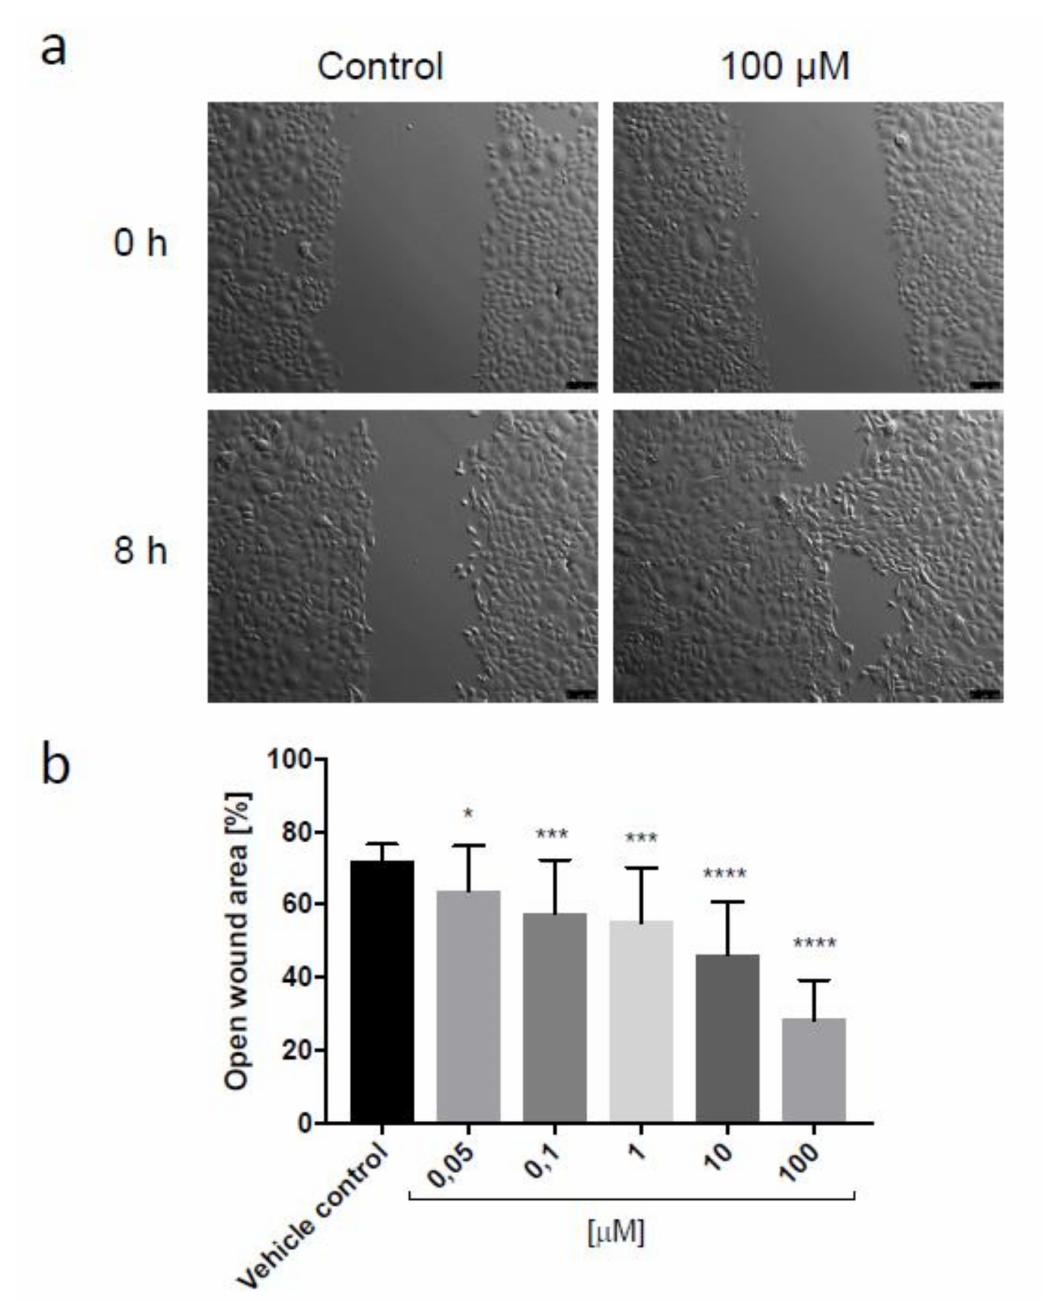
Figure 8. Representative wound closure images (scratch assay) of keratinocytes incubated in the presence of 100 µ M lupeol isonicotinate or vehicle control, immediately after the scratches had been made and after 8 h. Scale bar = 100 µ m ( a ). Relative open wound area ( b ); data presented as mean values ± SD from two independent experiments, each bar corresponds to 15–18 wound fields of view. Statistical analysis by multiple comparison one-way ANOVA: * p ≤ 0.05; *** p ≤ 0.01; **** p ≤ 0.0001 compared with the vehicle